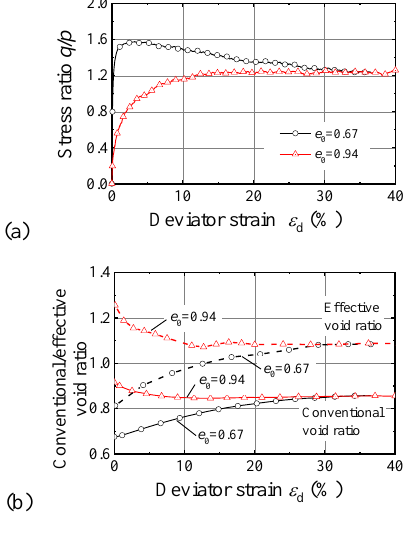
Table 1 Summary on the formulations of contact behavior. Interaction Contact response Stiffness Resistance Normal —